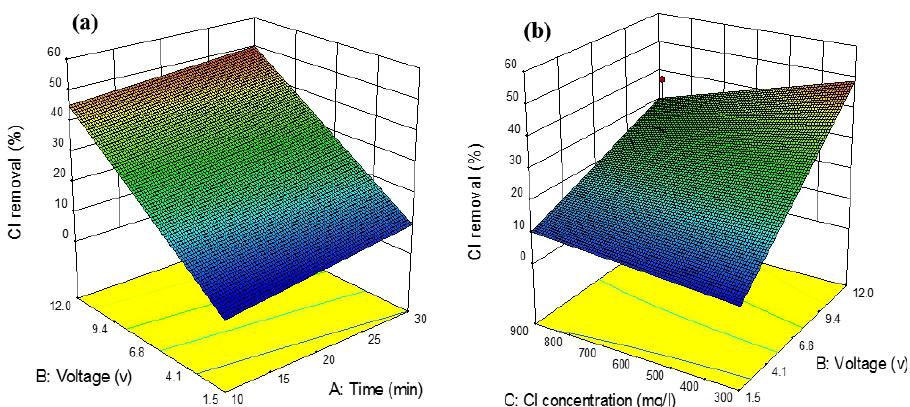
Fig. 4. 3-D Plots for effects of a) consumption voltage and process runtime (Cl − ion initial concentration: 300 ppm) and b) c onsumption voltage and Cl − ion initial concentration (process runtime: 30 minutes) on Cl − ion removal rate